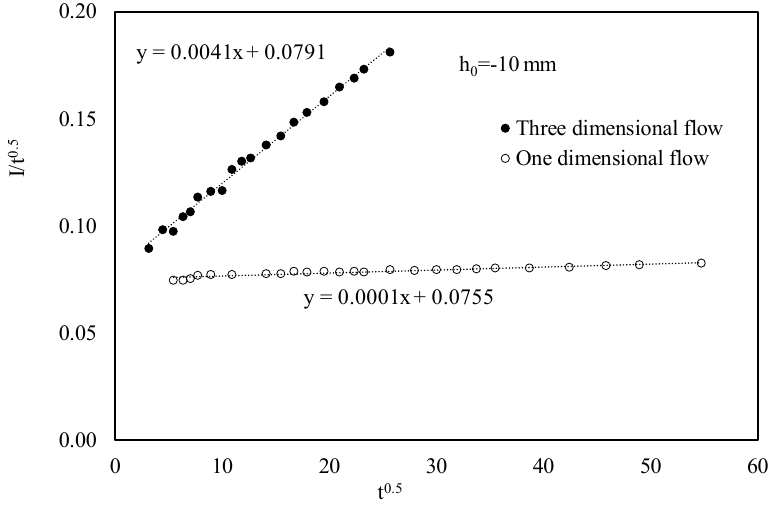
Figure 2. Linear representation of three- and one-dimensional experimental infiltration data and fitted linear lines for pressure head h 0 = − 10mm, for Loam